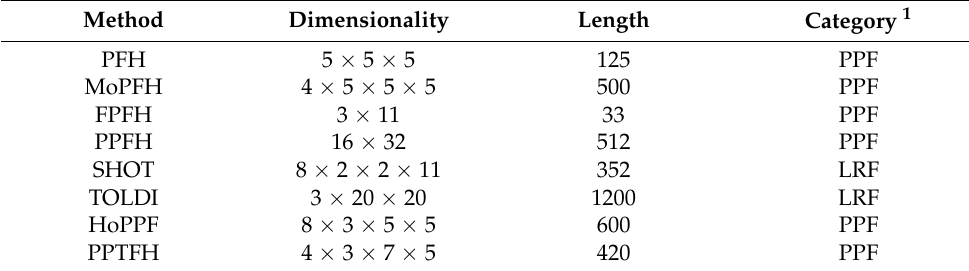
Table 1. Parameter settings for the state-of-the-art